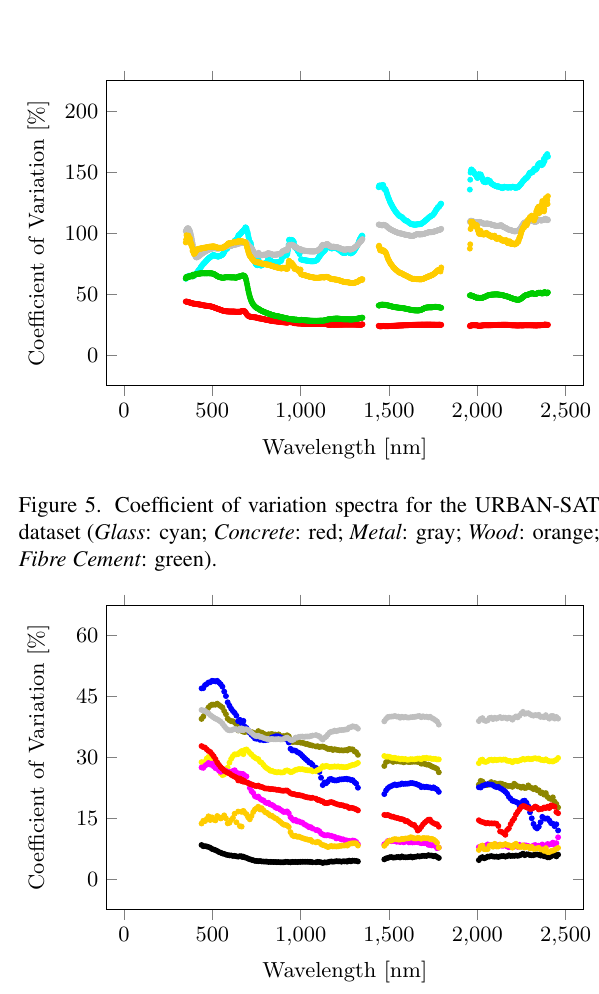
Figure 6. Coefficient of variation spectra for the Santa Barbara dataset ( Composite : olive green; Gravel : blue; Metal : gray; As- phalt : black; Tile : yellow; Tar : magenta; Wood : orange; Con- crete :